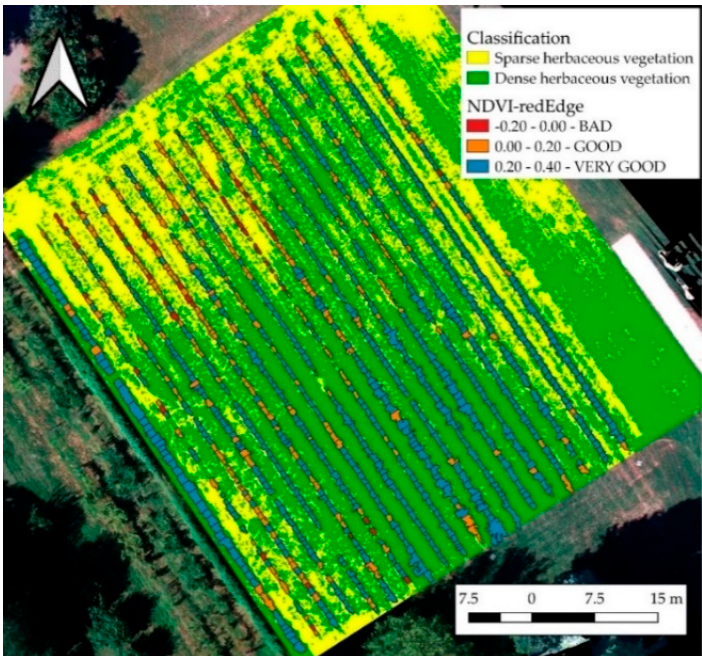
Figure 9. The result of the classification and the segmentation of the single trees. The image shows the example of NDVI values calculated on the Red Edge band for each plant. NDVI-Red Edge was classified in BAD (<0.00), GOOD (0.00–0.20) and VERY GOOD (>0.20).